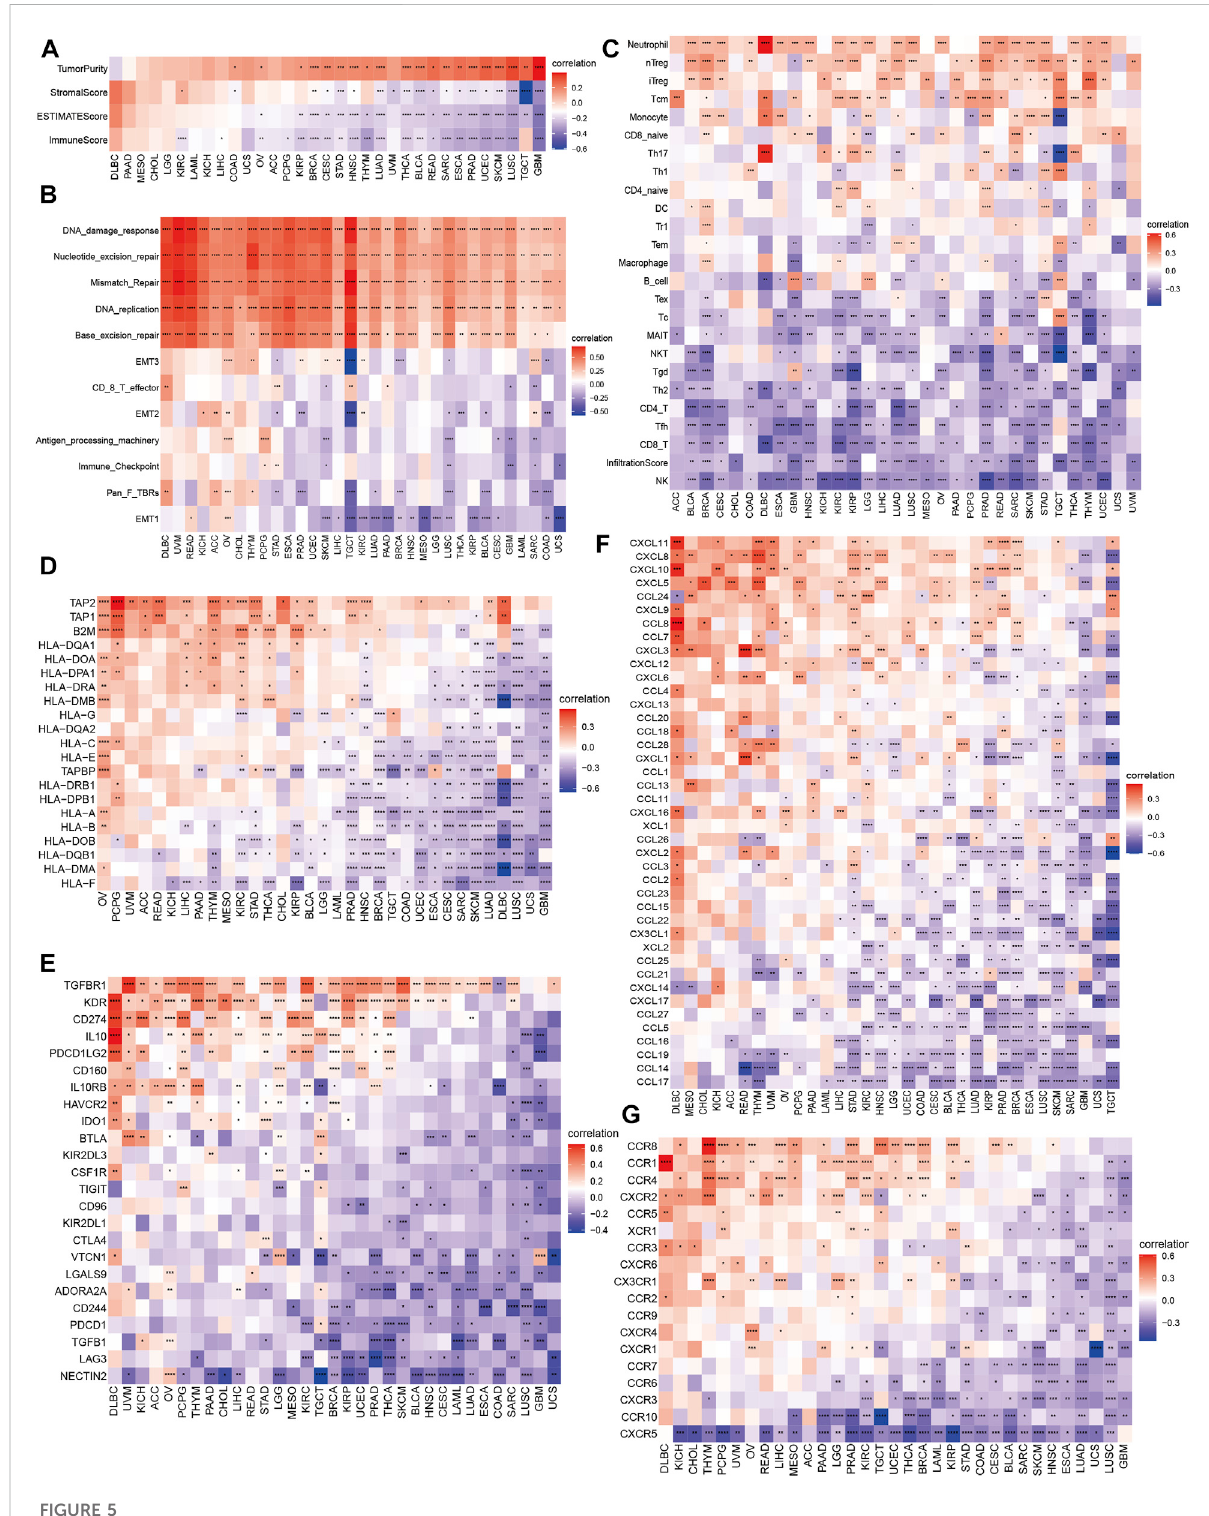
FIGURE 5 Correlation ofm7G modi fi cation level andimmunefeaturesin 33cancers. (A) Tumormicroenvironment. (B) Immune related pathways, matrix/ metastasis related pathways and DNA damage/repair related pathways. (C) Immune cell subsets. (D) Major histocompatibility complex-related genes. (E) Immune suppression genes. (F,G) Chemokines and their